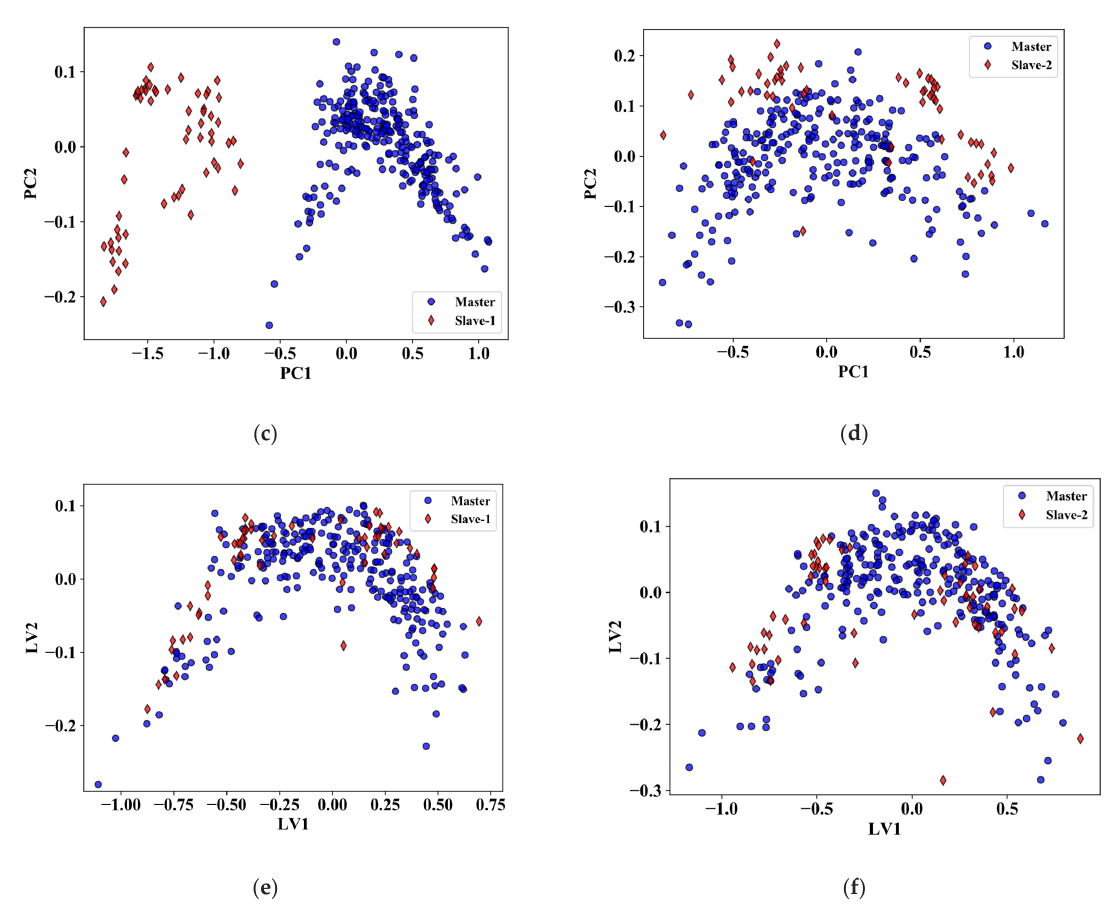
Figure 6. Latent space representations: ( a , b ) projections of master along with slave–1 and slave–2 data on the first 2 components of TCA, respectively; ( c , d ) projections of master along slave–1 and slave–2 data on the first 2 components of PCA, respectively; and ( e , f ) projections of master along with slave–1 and slave–2 data on the first 2 LVs of di-PLSR, respectively.